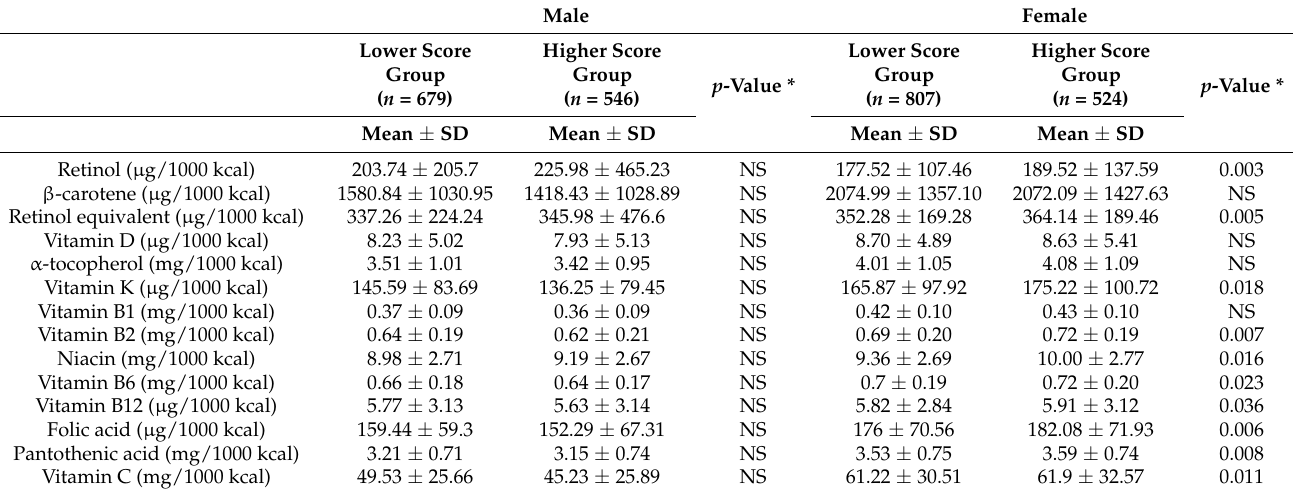
Table 2. Comparisons of the nutrient intakes according to Physical Component Summary (PCS) groups.